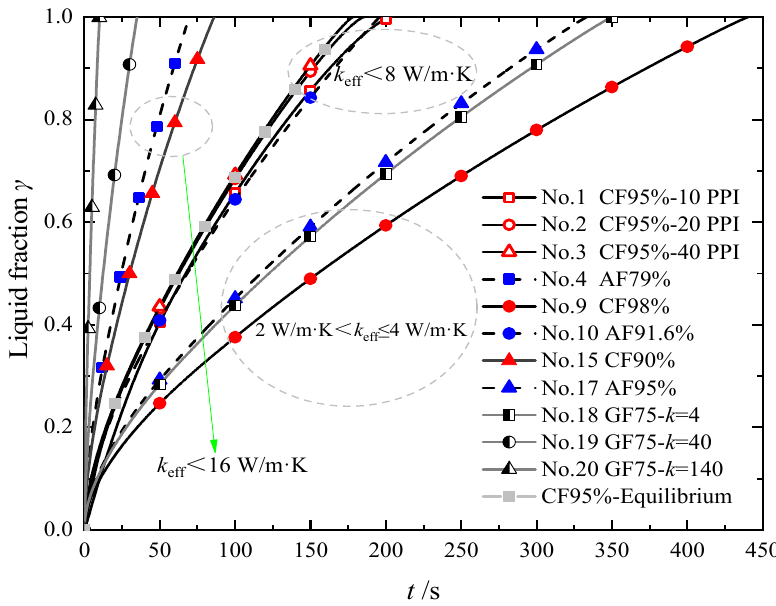
Figure 8. Liquid fraction vs. time for different alternatives.